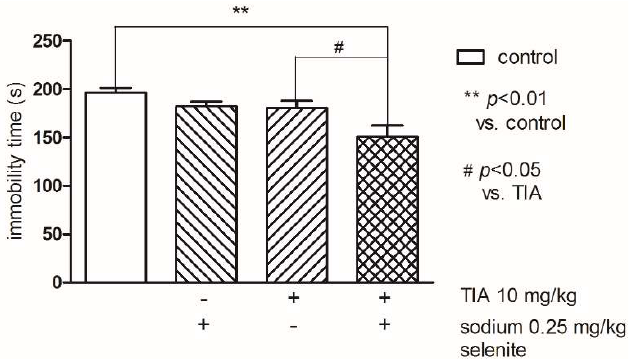
Figure 5. The effects of combined administration of Se and tianeptine (TIA) on the total duration of immobility in the FST in mice. The values represent the mean ± SEM. Sodium selenite was injected IP 30 min before the test. ** p < 0.001 vs. control vehicle-treated group, # p < 0.05 vs. TIA (Bonferroni’s test).